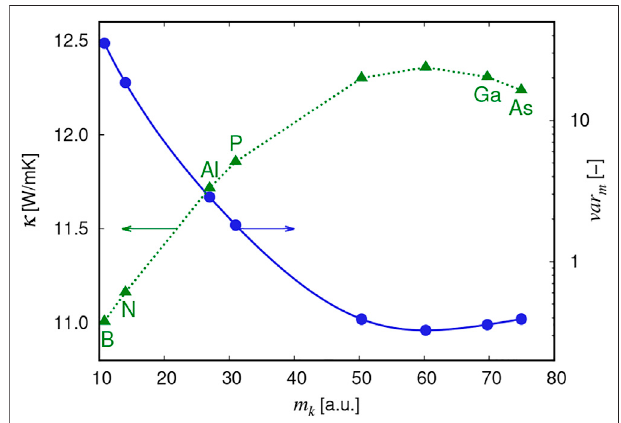
FIGURE 3 | Thermal conductivity (green triangles) in Si 0.5 Ge 0.5 as a function of the atomic mass m k of the dopant with a concentration of 10 21 cm − 3 and mass variance (solid line, right y -axis) according to Eq. 9 . Circles indicate the mass variance of the dopants calculated